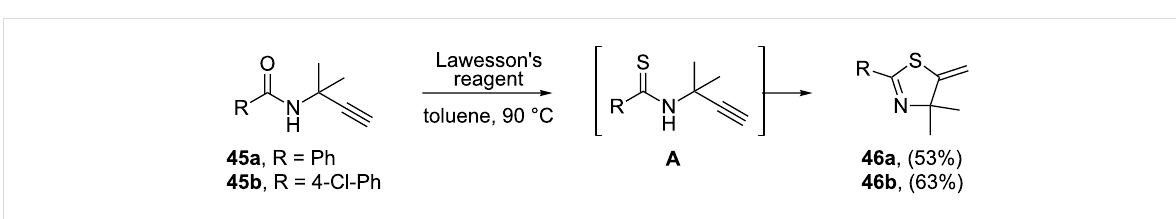
Scheme 12: Synthesis of dihydrothiazoles 46 through the treatment of N -propargylamides 45 with Lawesson’s reagent.